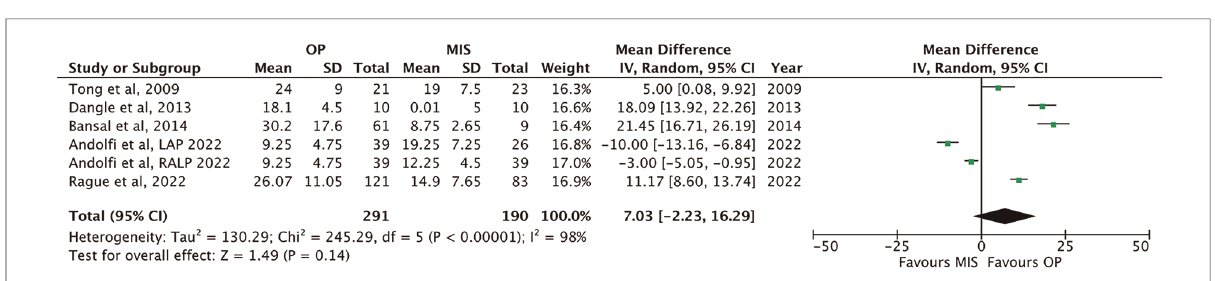
FIGURE 7 Forest plot comparison of the length of follow-up between OP and MIS in infants.